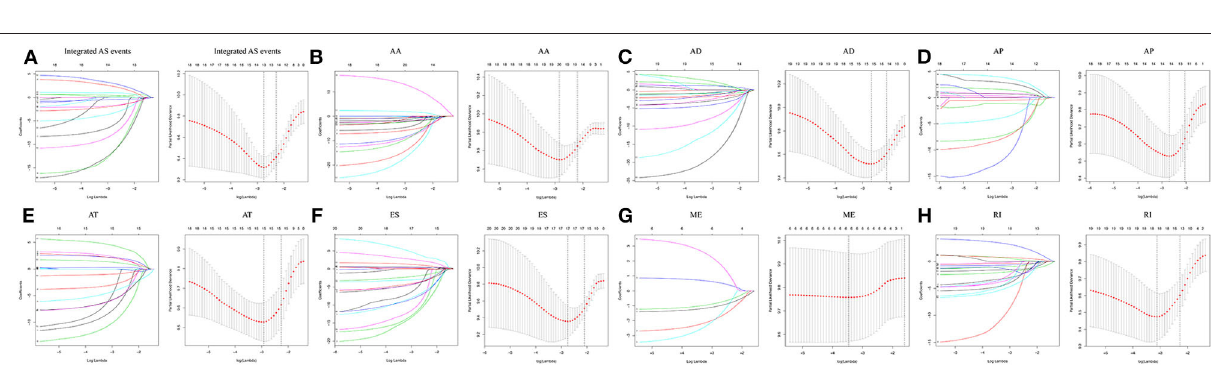
FIGURE 3 | The prognosis-associated AS events were screened by LASSO regression analysis for all AS types combined and for each of the 7 AS types separately. Left panel (A–H) The coefficients are plotted against log( λ ). A vertical line is shown at the value selected using 10-fold cross-validation, where the optimal λ results in ten features with nonzero coefficients. Right panel (A–H) : Optimal parameter ( λ ) selection in the LASSO model used 10-fold cross-validation via minimum criteria. The partial likelihood deviance (binomial deviance) curve is plotted vs. log( λ ). Dotted vertical lines are shown at the optimal values selected using two different criteria: the minimum and 1 standard error of the